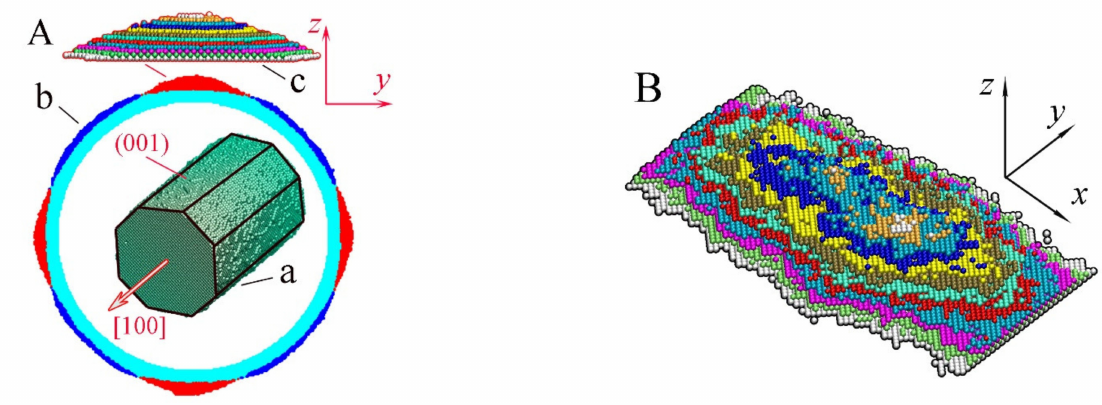
Figure 1. ( A ) Morphology of a thick nanowire with an FCC lattice structure at the initial stage of its evolution: (a) the typical shape of an initially cylindrical nanowire in the absence of the roughening transition effect; (b) nanowire cross-sections with an initial radius of r nw = 55 a ( a —lattice constant) in the area of its maximum size along the y and z axes in two variants of its dynamics for different values of the parameter p at a fixed α = 1: the physical meanings of parameters α and p are presented in the description of the model (see Section 2). Atoms marked in cyan and blue represent the near- surface atoms when p = 0.7. The cyan and red atoms correspond to the case with p = 0.825 (the case of stimulated surface diffusion of atoms). Both cross-sections are calculated at a time moment t = 3 × 10 6 MC time steps; (c) detailed representation of a hillock structure by multi-colored (001) atomic layers; ( B ) a typical hillock having formed on the side nanowire surface by the time moment t = 3 × 10 6 MC time steps. The sizes of the lowest (001) layer (marked in red) are around l x ∼ 53 a , l y ∼ 23 a